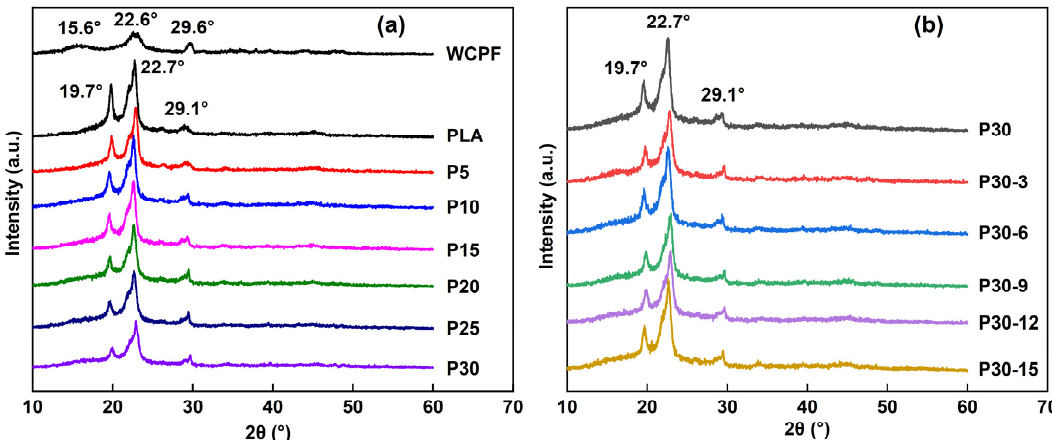
Figure 5. ( a ) XRD patterns of WCPF, PLA, and WCPF/PLA composite with different contents of WCPF. ( b ) XRD patterns of the WCPF/PLA composite with 30 wt% WCPF which treated by different contents of KH-550 coupling agent.